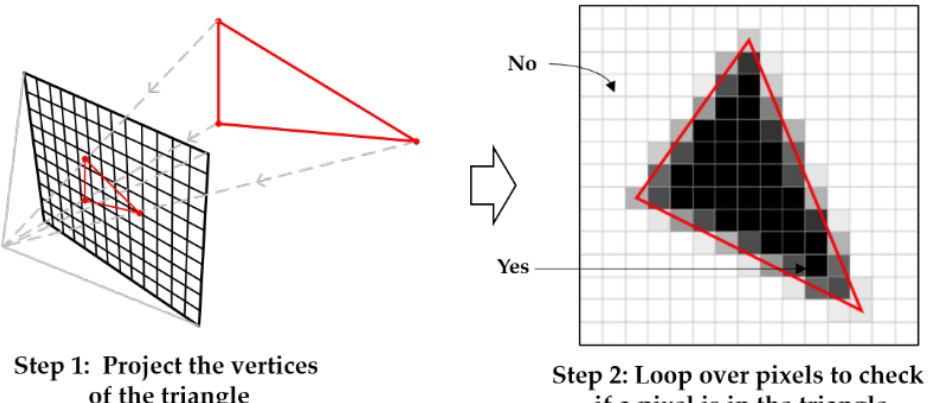
Figure 3. Flowchart of the 2D nesting algorithm.